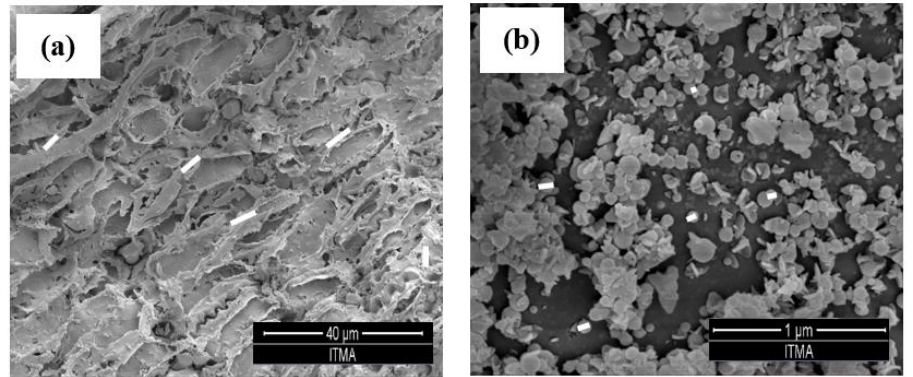
Figure 1. ( a ) RHA after grinding process, and ( b ) aluminum